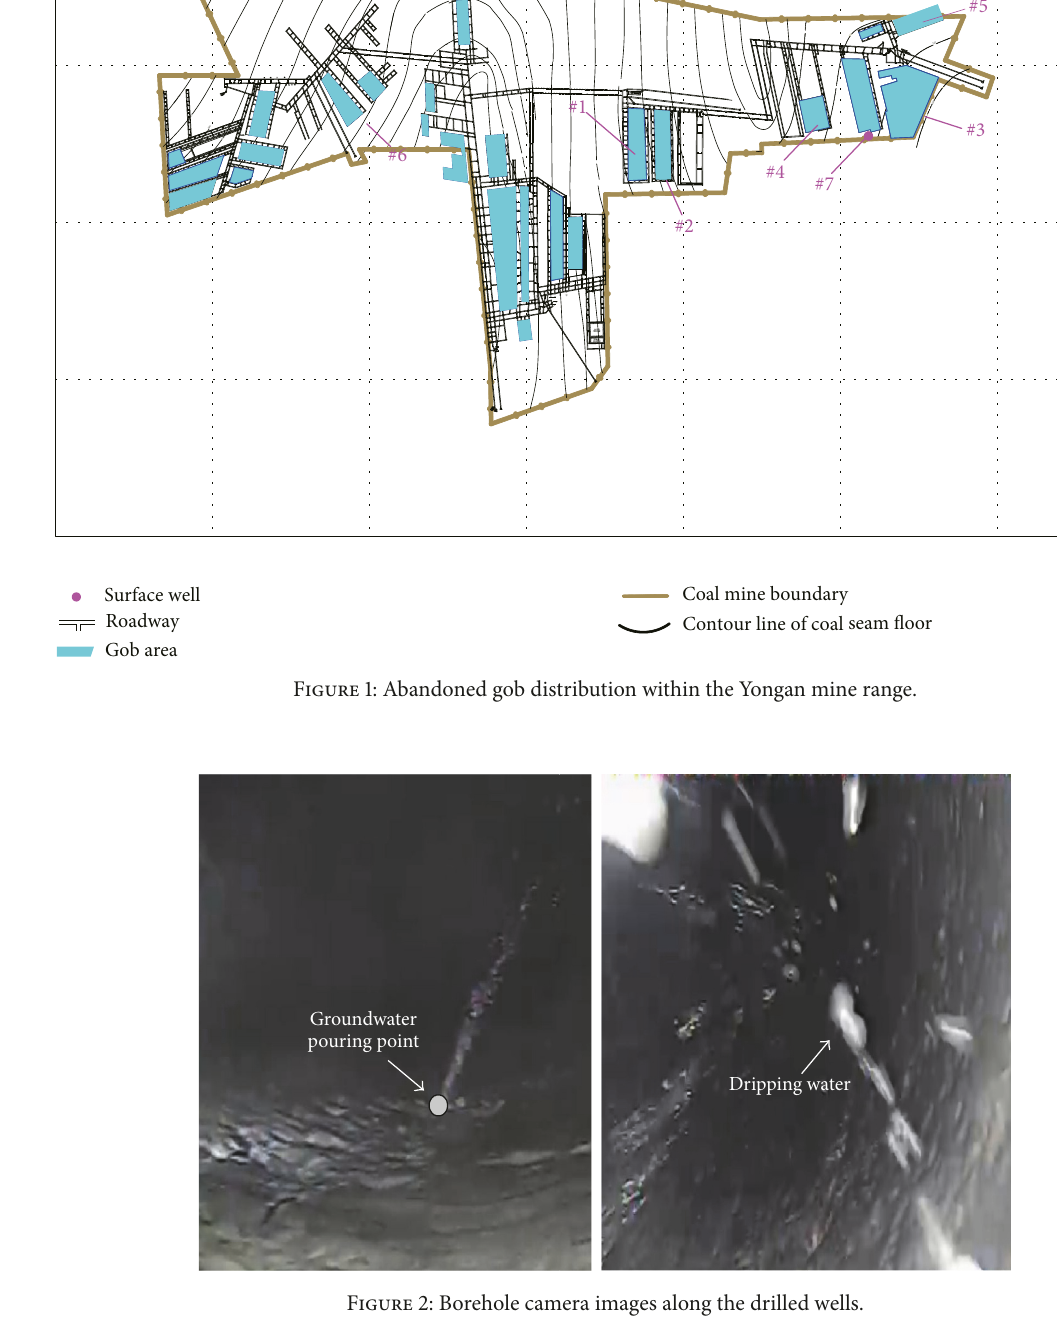
Figure 2: Borehole camera images along the drilled